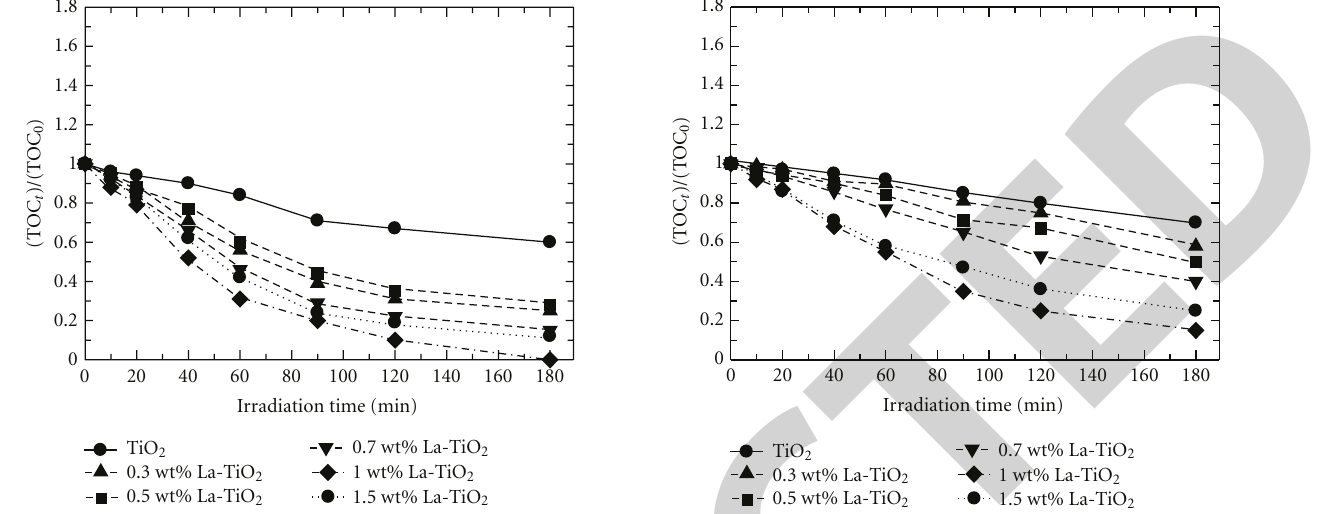
Figure 8: Comparison of photocatalytic mineralization of MCP using TiO 2 and La-doped TiO 2 photocatalysts. (MCP concentra- tion = 40 mg L − 1 ; catalyst amount = 100mg/100 mL; solution pH = 5; λ = 254 nm).